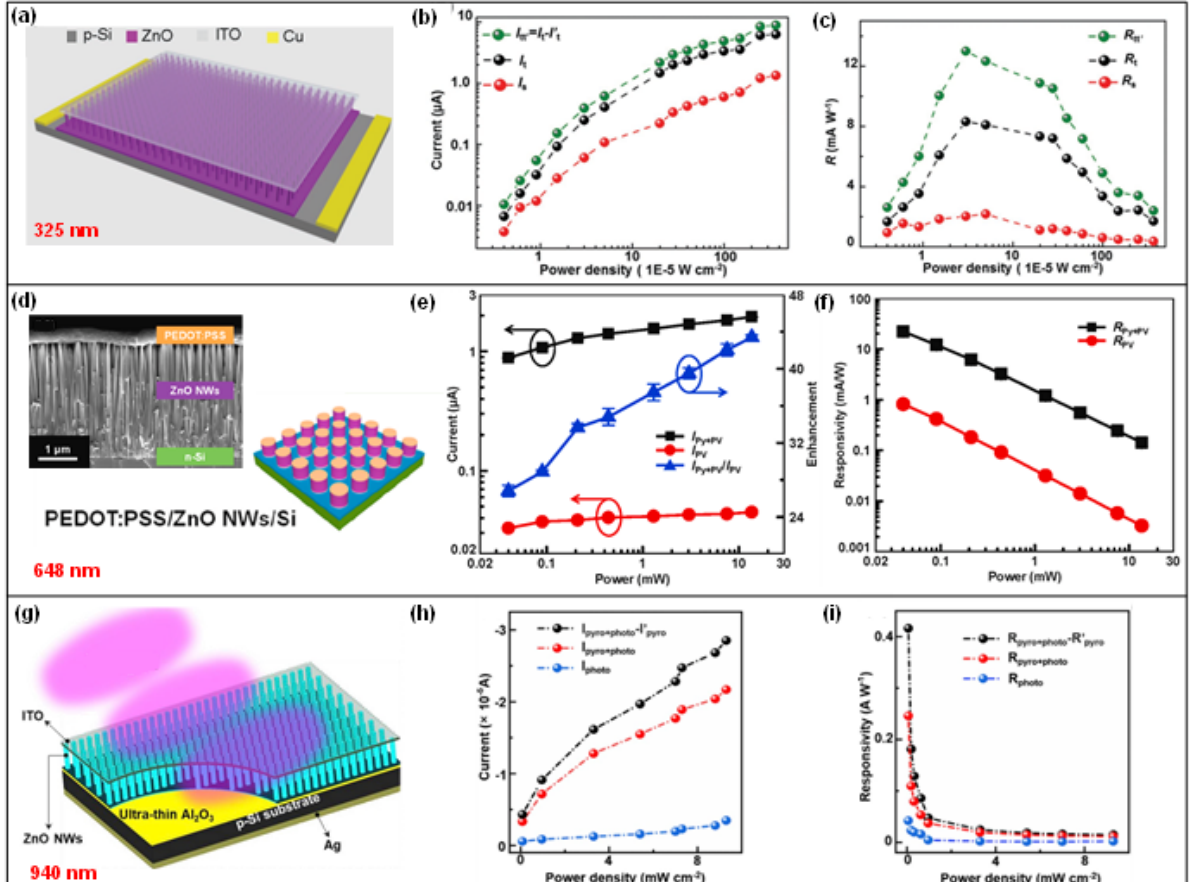
Figure 3. Pyro-phototronic-effect-enhanced performances of UV sensors based on p-Si/n-ZnO under different wavelengths. ( a ) Structure of p-Si/n-ZnO UV sensors; ( b , c ) The absolute transient (I t , in black), absolute stable (I s , in red), and relative transient (I tt′ , in olive) currents, and the corresponding photoresponsivity change with the power densities. Reproduced with permission from [32]. Copy- right 2016 Wiley; ( d ) Structure and scanning electron microscopy images of the p-PEDOT:PSS/n- ZnO nanowires/n-Si tri-layer heterojunction; ( e ) The specific photocurrents I Py+PV and I PV and the enhancement factor at each illuminant power; ( f ) The specific responsivities R Py+PV and R PV at each illuminant power. Reproduced with permission from [37]. Copyright 2020 Elsevier; ( g ) Structure characterizations of the p-Si/Al 2 O 3 /n-ZnO nanowires heterostructured near-infrared photodetector; ( h ) The variation of steady photos, absolute transient and relative transient currents with the power density; ( i ) The corresponding photoresponsivity as a function of the power density. Reproduced with permission from [38]. Copyright 2020 Elsevier.